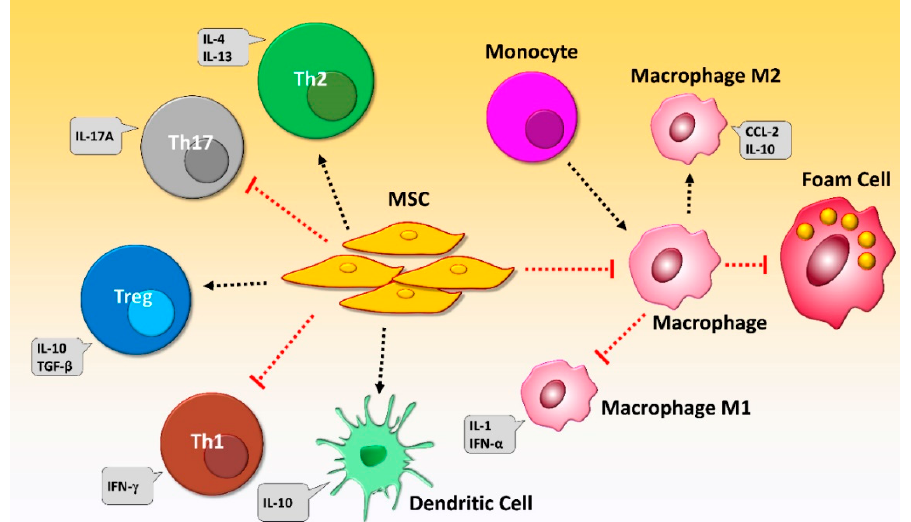
Figure 1. Schematic illustration of anti-inflammatory and immunomodulatory characteristics of mesenchymal stem cells (MSCs) in regulating immune cells. MSCs can suppress the differentiation of Th1 and Th17 cells and the secretion of cytokines specific to these cells. MSCs induce the development of Th2 and regulatory T (Treg) cells, which in turn produce immunosuppressive mediators. MSCs orchestrate the balance between the development of M1 and M2 macrophages. M1 macrophages usually produce immunostimulatory cytokines, while the major cytokine profile of M2 macrophages has immunosuppressive properties. Type 2 dendritic cells (DCs) are developed under the impression of MSCs and produce IL-10. MSCs prevent the transformation of macrophages into foam cells in atherosclerosis. Foam cells are low-density lipoprotein (LDL)-laden macrophages contributing to atherosclerosis through the formation of plaques. The foam cell formation is a consequence of the disruption of balance between cholesterol uptake and cholesterol efflux in macrophages present at intima. MSCs, however, have the potential to prohibit foam cell formation via the reduction of cholesterol uptake and up-regulation of IL-10, eliminating a risk factor for atherosclerosis development.